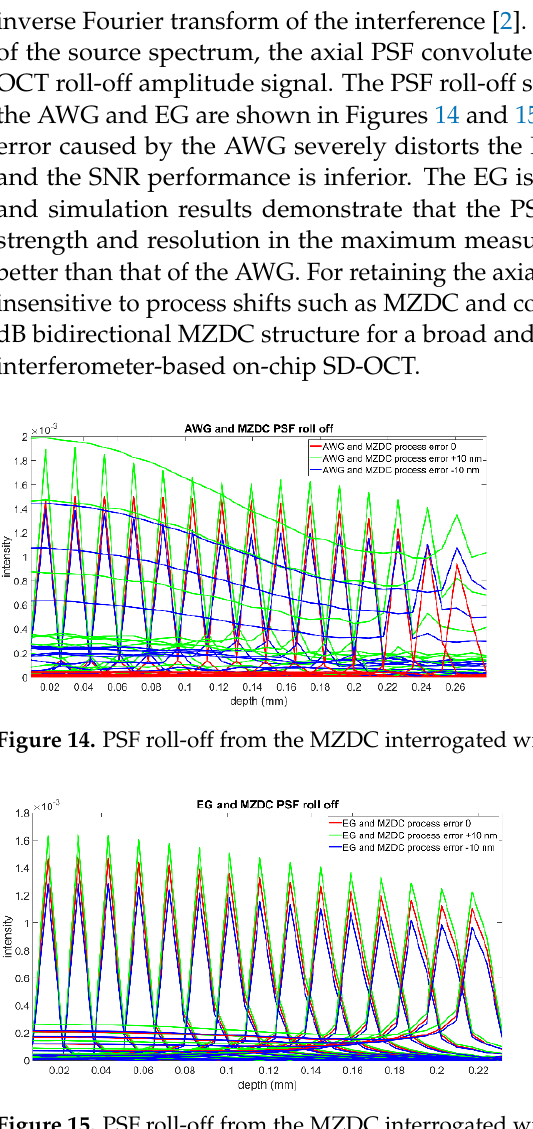
Figure 15. PSF roll-off from the MZDC interrogated with EG.